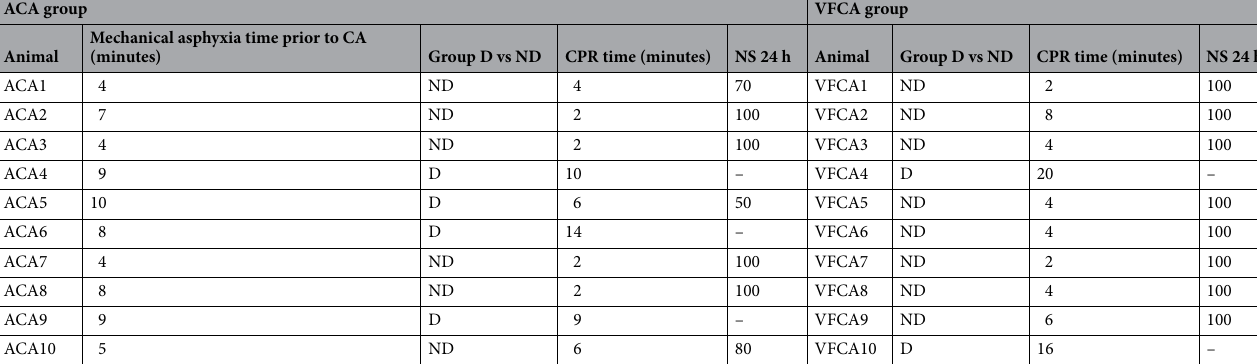
Table 1. Clinical and experimental parameters of the studied groups. D = damaged animals; ND = no-damaged animals; CPR = Cardio Pulmonary Resuscitation; NS = neurological